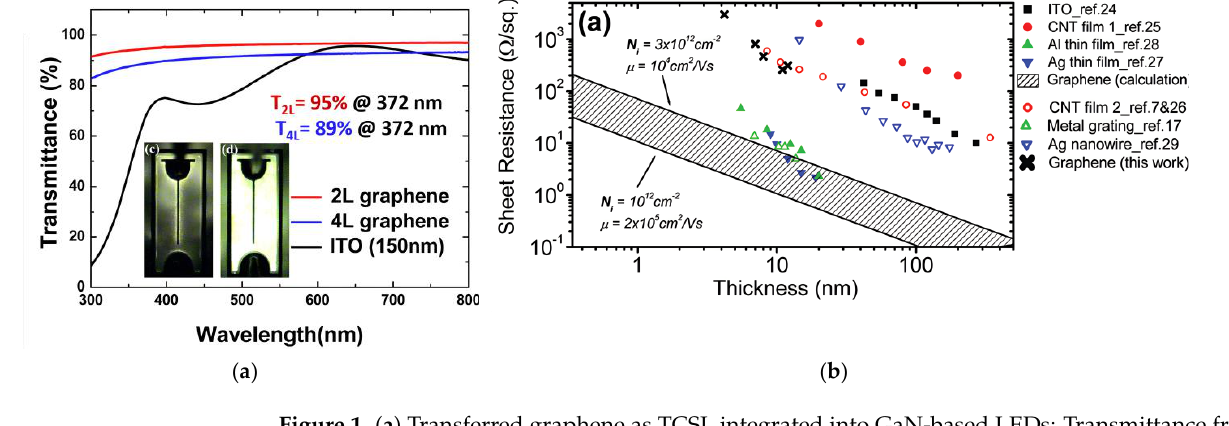
Figure 1. ( a ) Transferred graphene as TCSL integrated into GaN-based LEDs: Transmittance from 300 nm to 800 nm of 2L and 4L graphene in comparison to the typical transparent electrode ITO. Inset: optical images of light emission of a typical LED device (left) without and (right) with few-layer graphene. ( b ) Sheet resistance of different transparent conductors versus film thickness. ( a ) Repro- duced with permission from [23]. Copyright 2011 American Institute of Physics. ( b ) Reproduced with permission from [48]. Copyright 2010 American Chemical